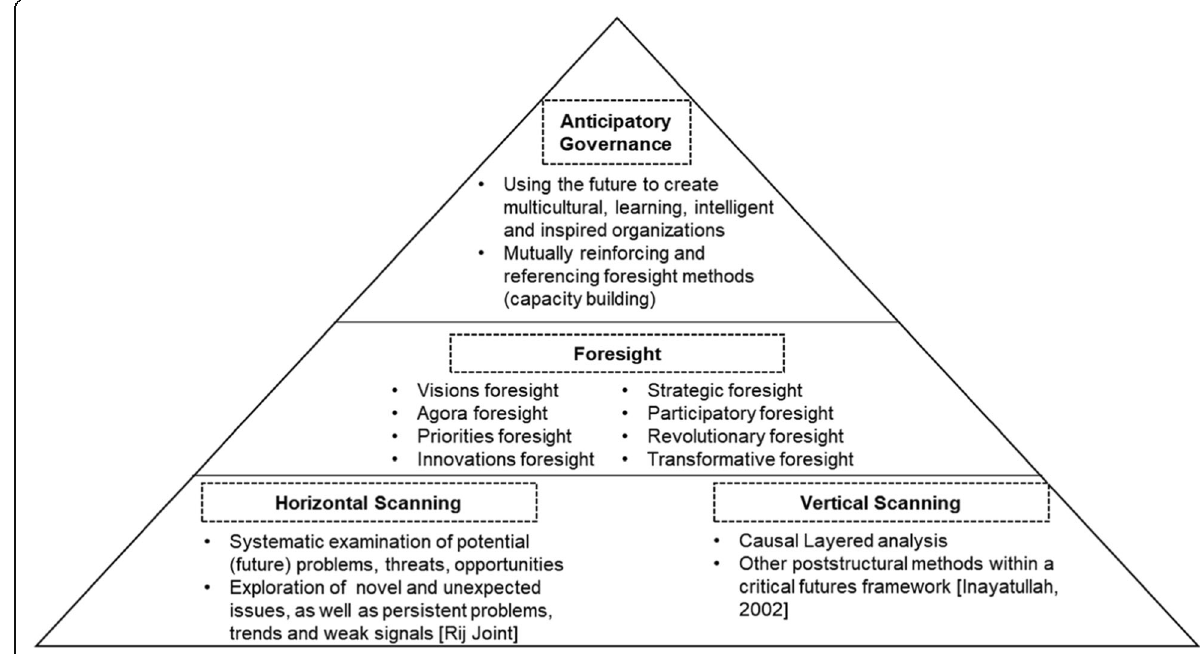
Fig. 1 Vertical layers of horizon scanning, foresight, and the